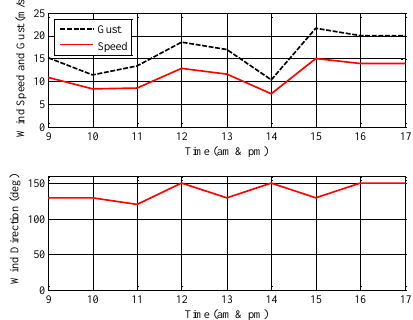
Figure 8. Wind speed and direction during the day when the experiments were conducted.